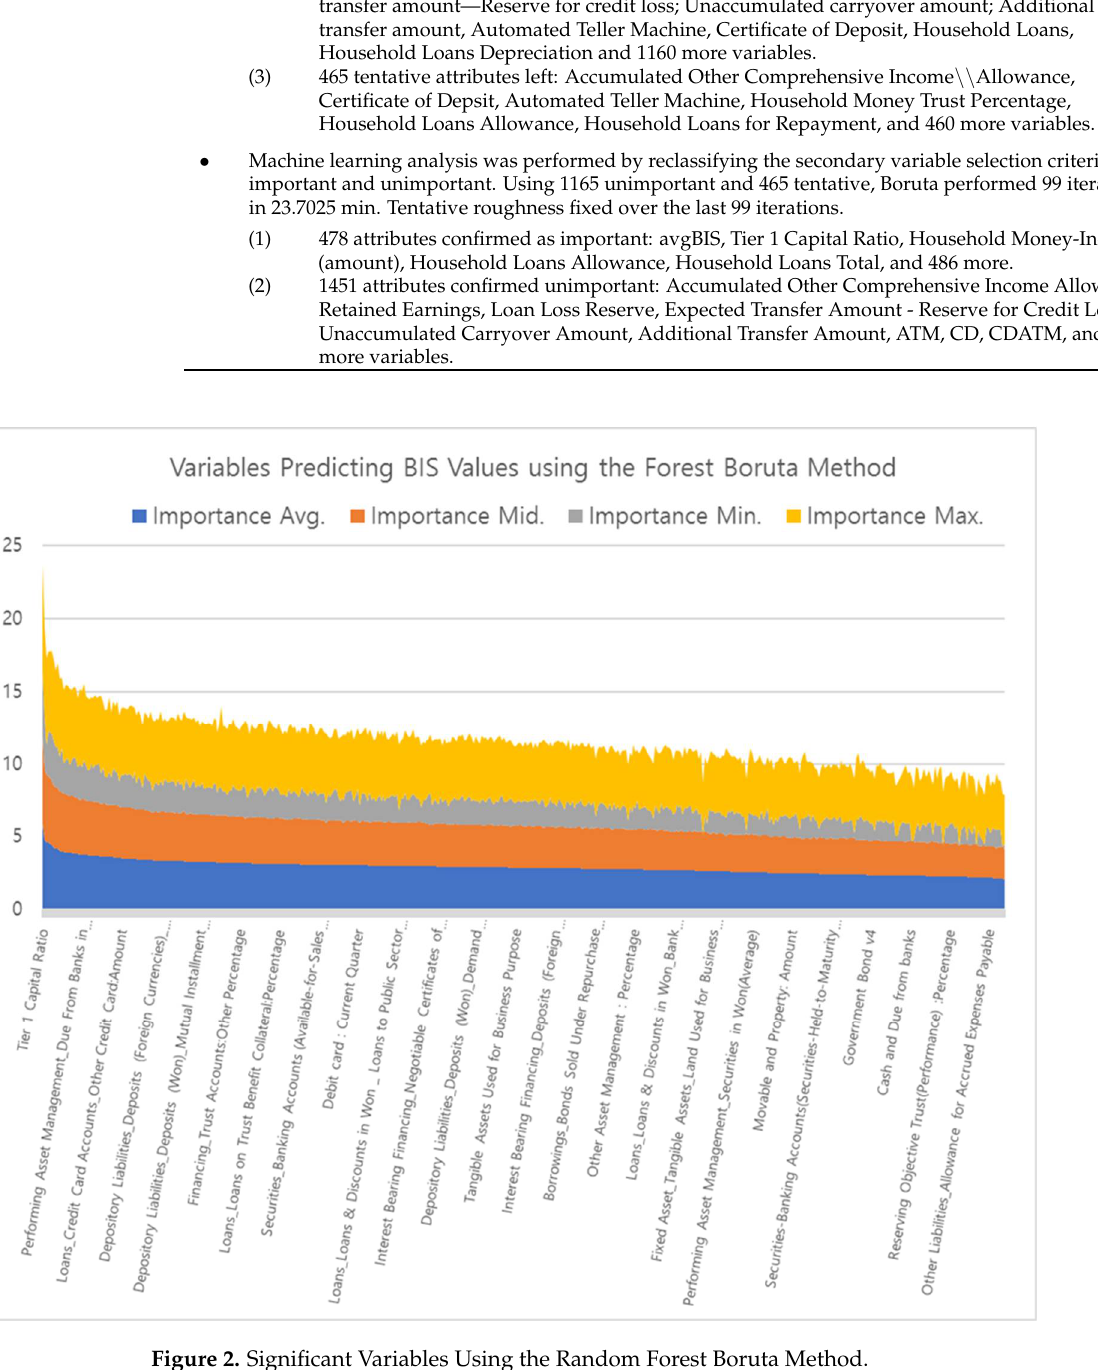
Figure 2. Significant Variables Using the Random Forest Boruta